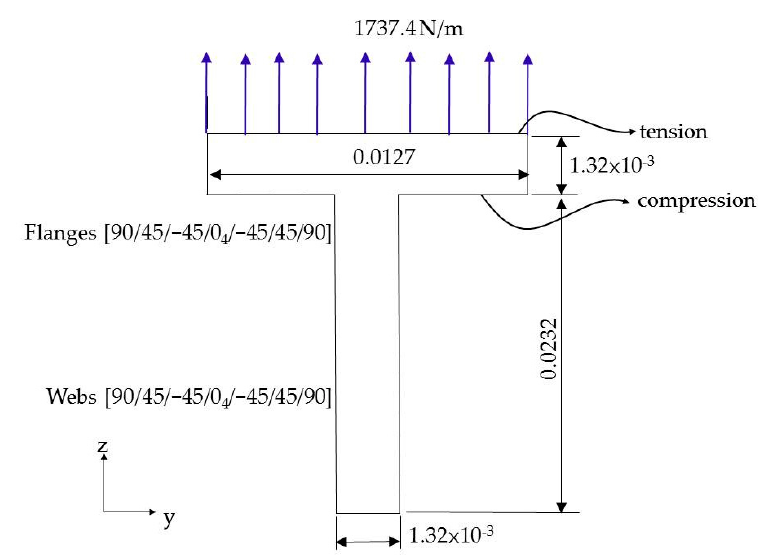
Figure 7. Structure and loading diagram of laminated composite T-beam. Table 1. Comparison of effective stiffness, stress, and deflection of